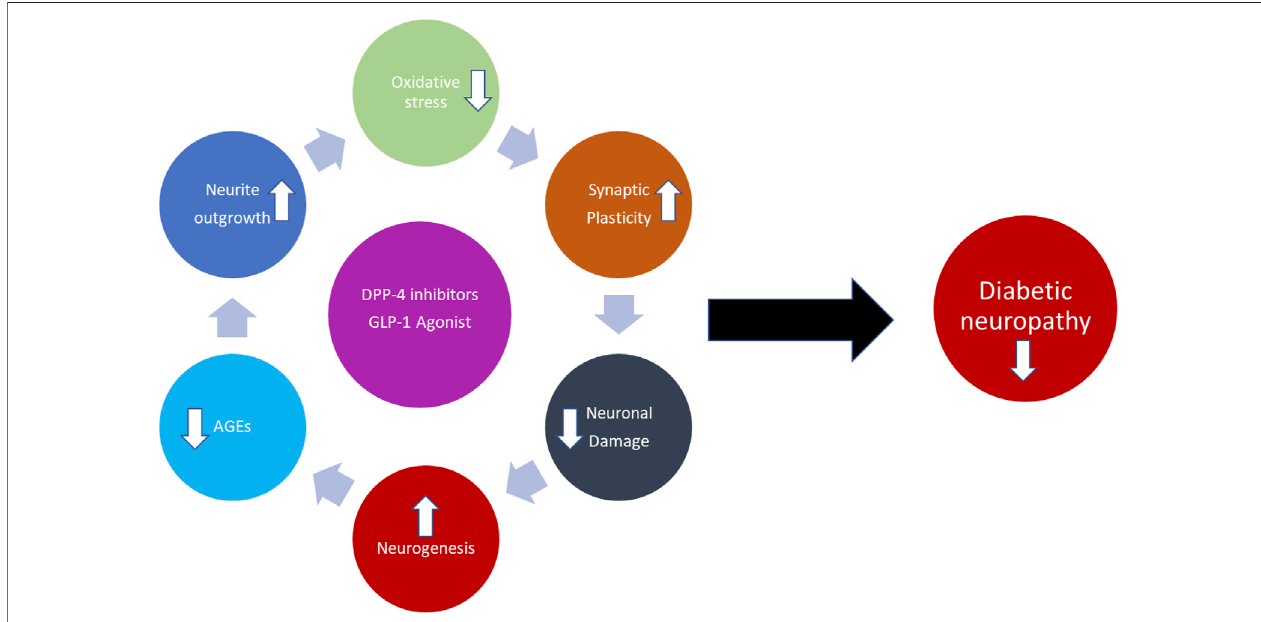
FIGURE 7 | Schematic illustration of the DNP protective effect of the GLP-1 agonist and DPP-4i.